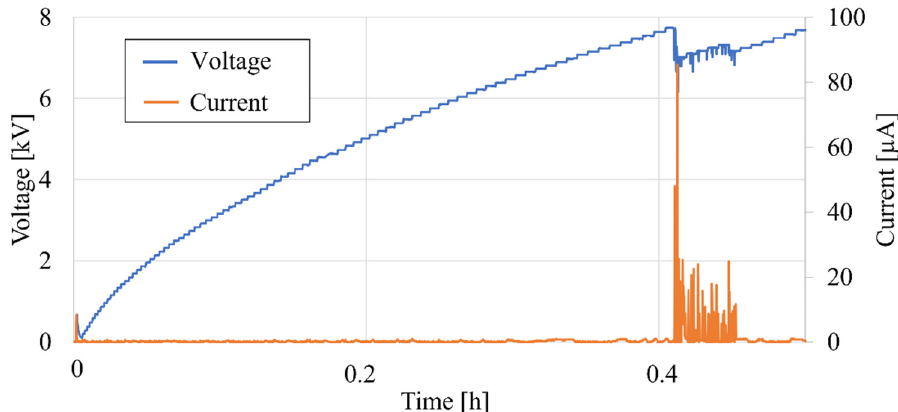
Figure 11. Focus on the voltage (blue line) and current (orange line) vs. time while a discharge occurs.